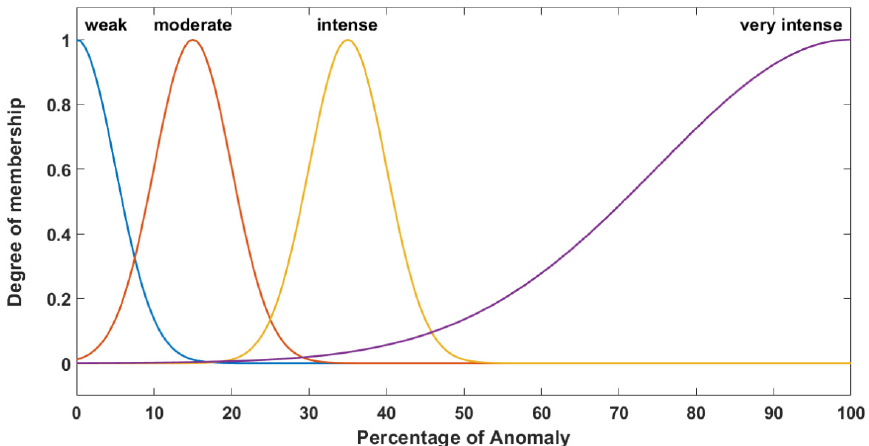
Figure 4. Membership functions of the input data.